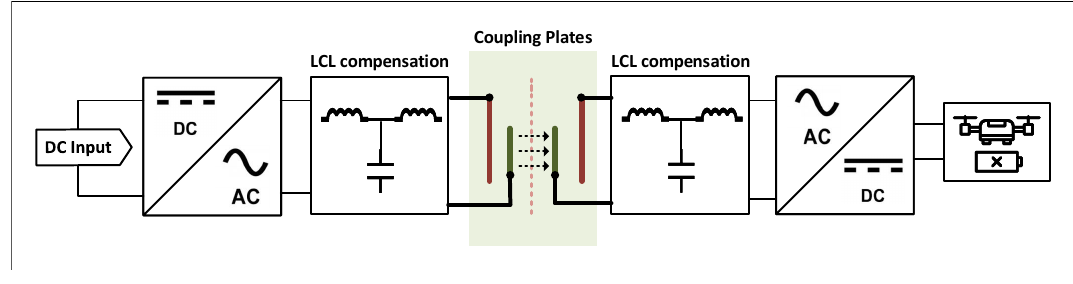
Figure 9. Double-sided LCL compensated circuit